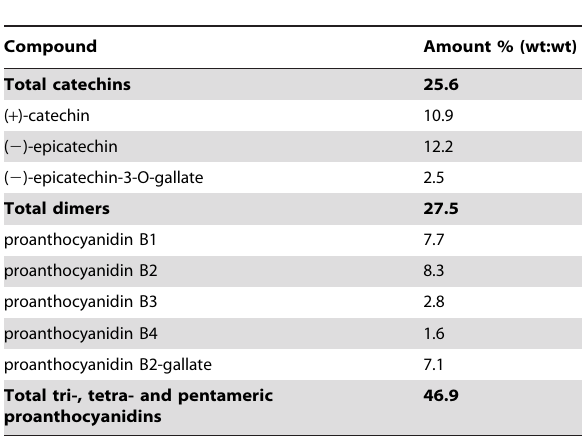
Table 1. Composition of monomeric and oligomeric